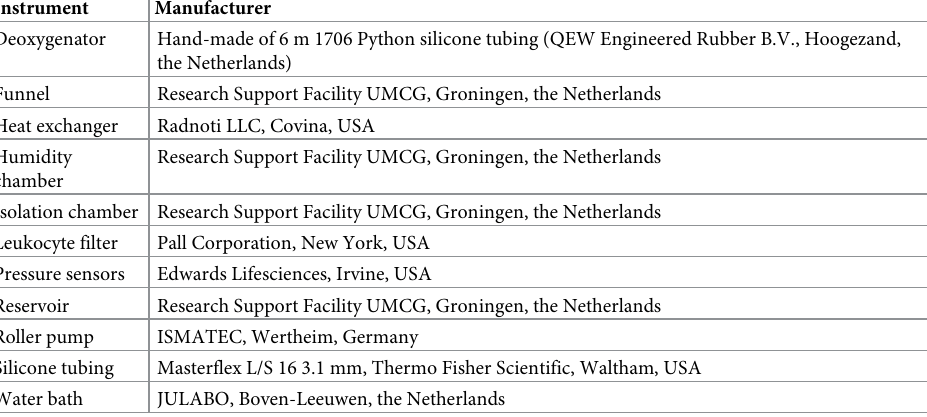
Table 2. List of instruments for the ex vivo lung perfusion